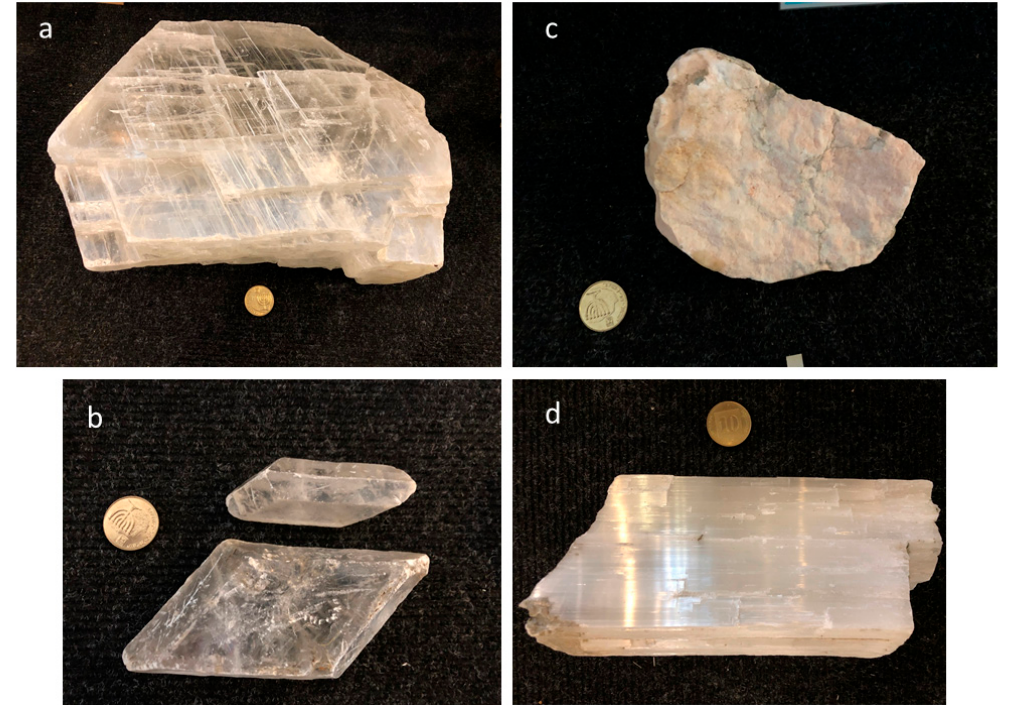
Figure 14. Common habits of gypsum. ( a , b ) selenite, ( c ) alabaster, and ( d ) satin spar. The diameter of the coin in the figure is 2.2 cm. Gypsum samples are from the Mineralogy and Petrology collection at the Institute of Earth Sciences, the Israeli National Natural History collections at the Hebrew University of Jerusalem.